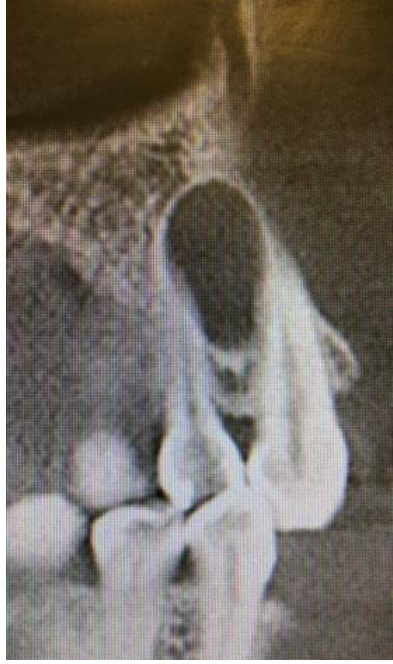
Figure 3. CBCT sagittal view of LPC.